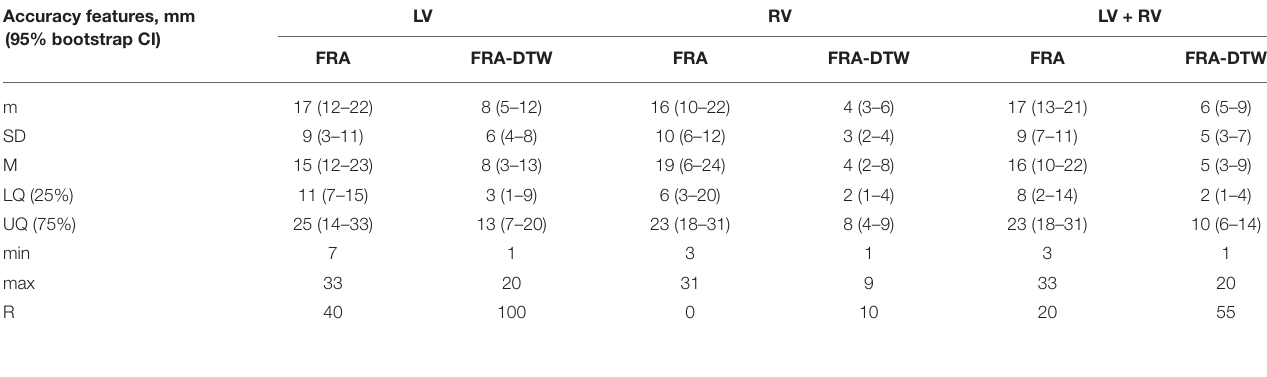
TABLE 2 | Main characteristics of ECGI accuracy for FRA and FRA-DTW algorithms. m, mean; SD, standard deviation; M, median; LQ, lower quartile; UQ, upper quartile; min, minimum; max, maximum, ratio of correctly detected early activation site’s surface-R (in percents). For the localization error characteristics, 95% bootstrap confidence interval (CI) is provided in parentheses.